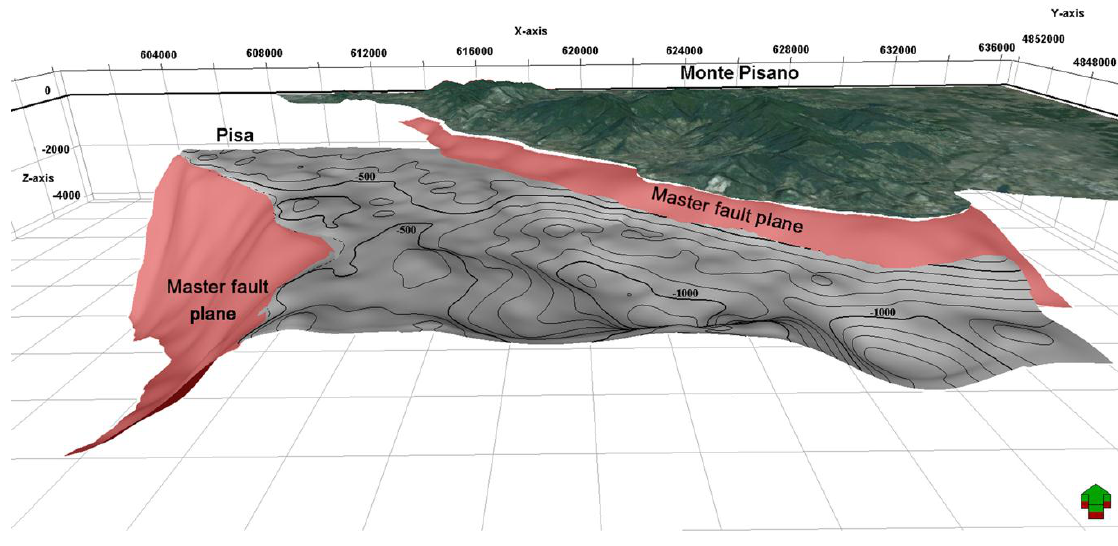
Figure 5. 3D view of the bedrock upper surface (isobaths in m a.s.l) and master faults of the basin. Elaborated by the inversion of gravity data. Coordinate system in meters.